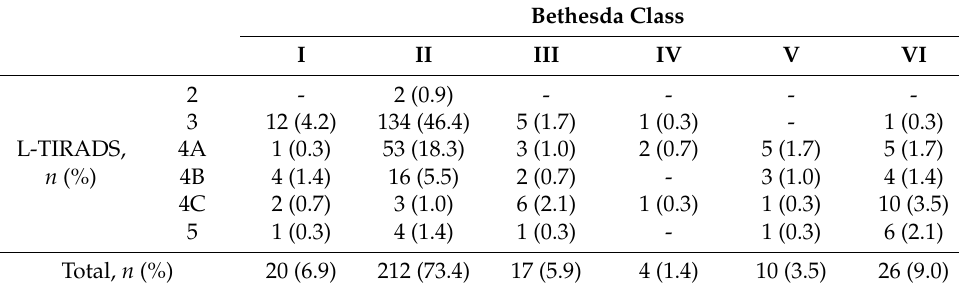
Table 1. Summary of L-TIRADS categories by Bethesda classes.